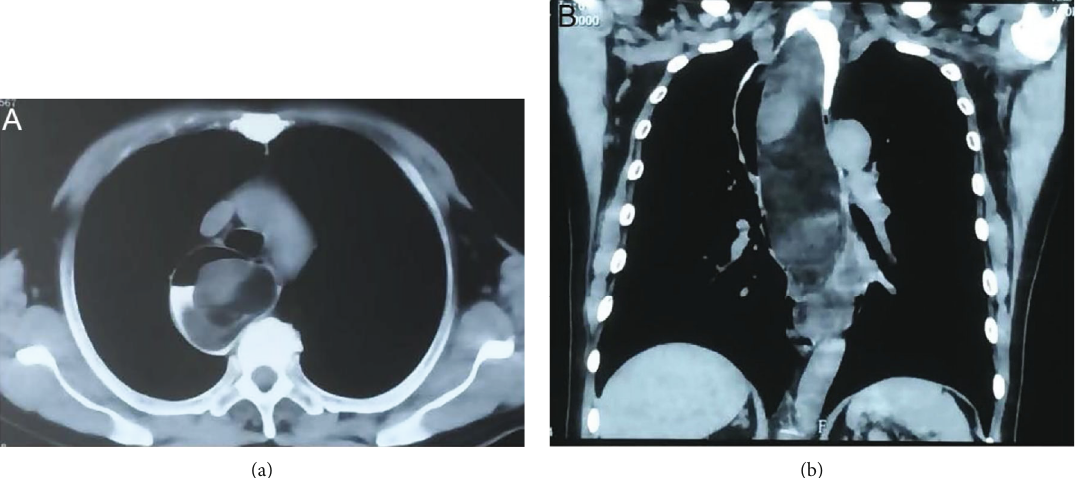
Figure 5: The esophagus was dilated; the right side of the esophageal lumen showed a large soft tissue mass with an irregular shape, a smooth surface with nonuniform density. Table 2: Treatment outcomes of 6 patients.